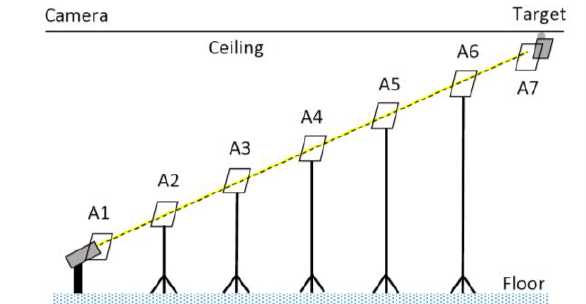
Figure 4. Schematic of floor mounted long focal length camera pointing though a series of thermocouples at a distant ceiling target.